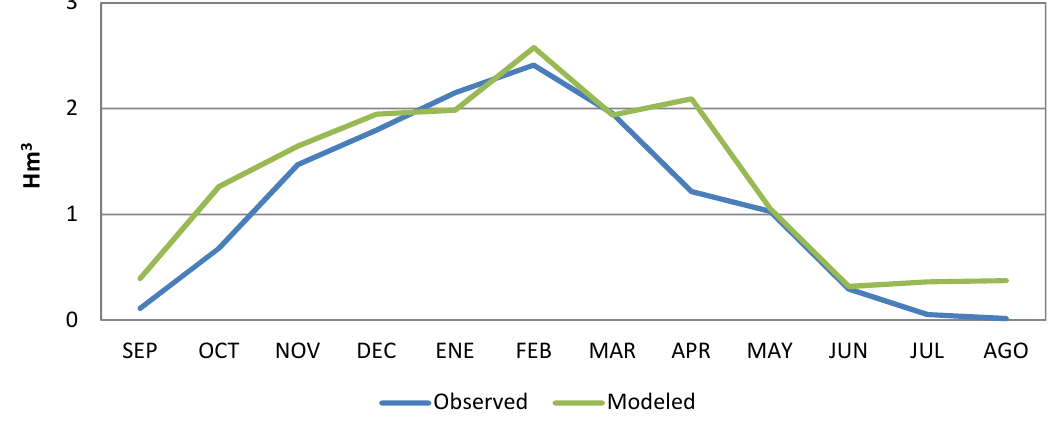
Figure 3 - Plot of observed vs modeled runoff volumetric rates